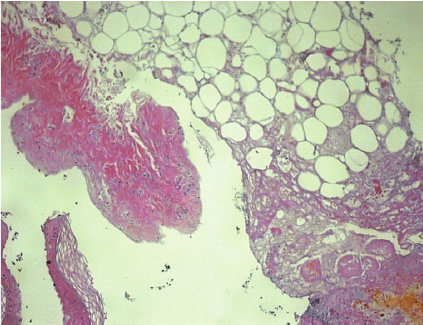
Figure 4: Fragment of necrotic skin with subcutaneous fat tissue and epidermis with subepidermal cleft (HE × 100).